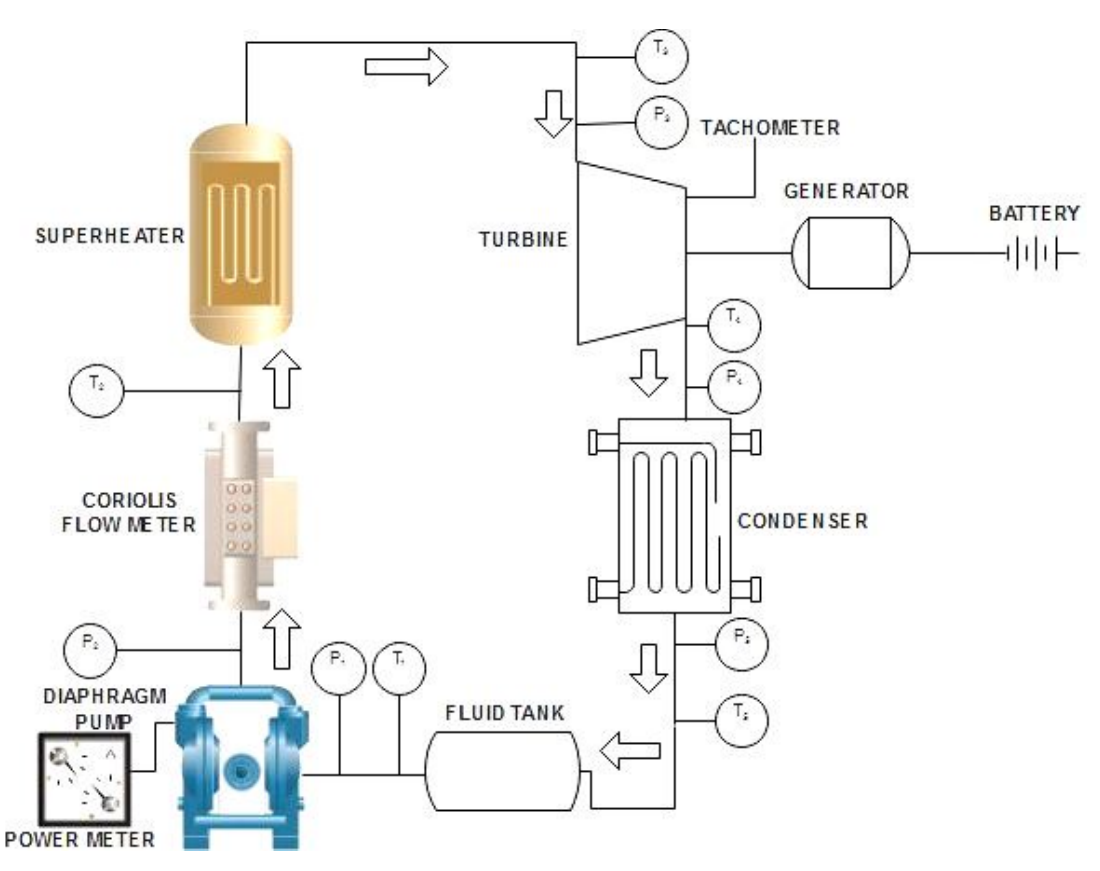
Figure 3. Flow diagram of the ORC prototype. Table 5. Uncertainty measurement of the various